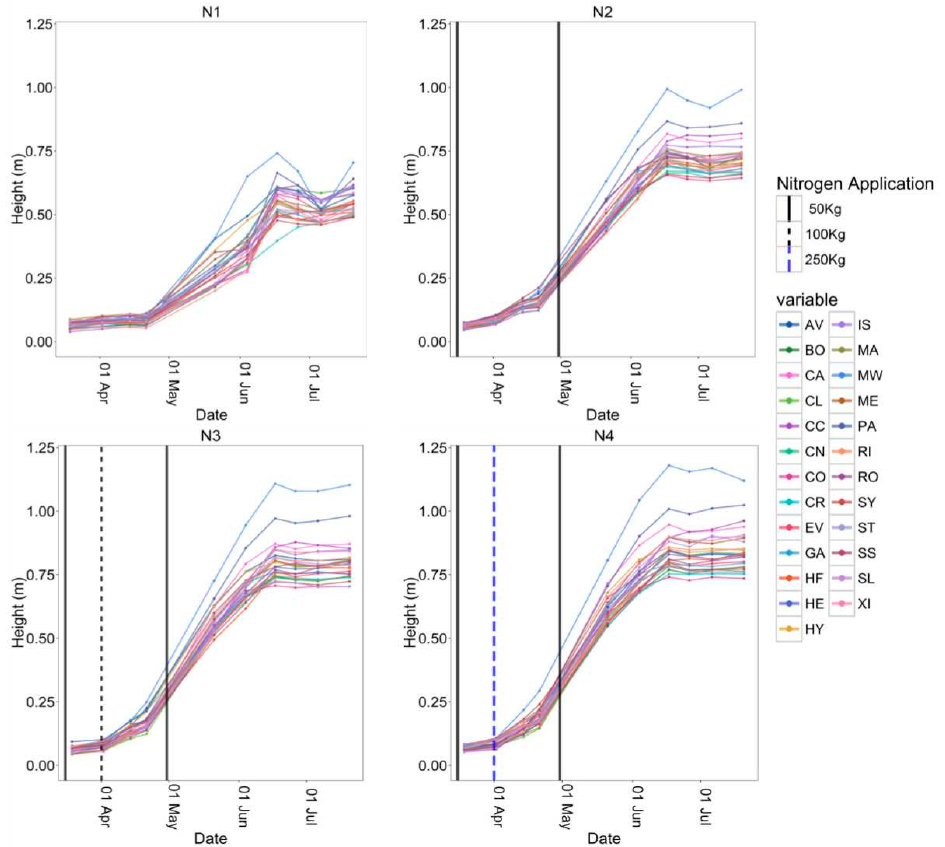
Figure 15. Comparison of crop height over the season grouped by nitrogen treatment. Vertical lines in each figure represent the date and quantity of nitrogen applied to plots for each treatment. All data represent the means of three replicates.